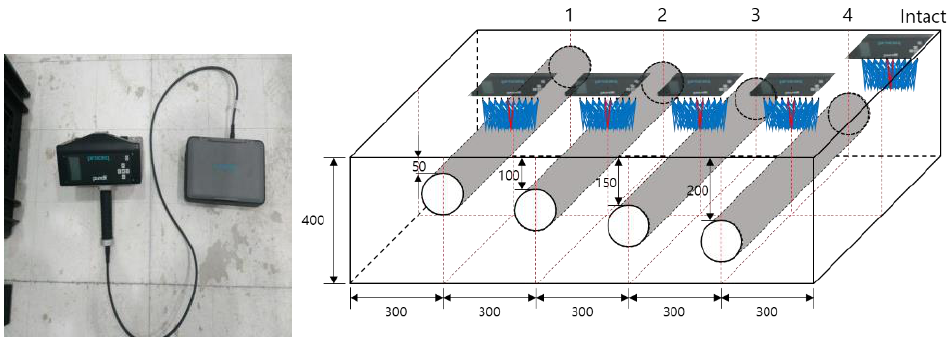
Figure 3. Shear wave measuring equipment and test procedure (dimensions in mm).